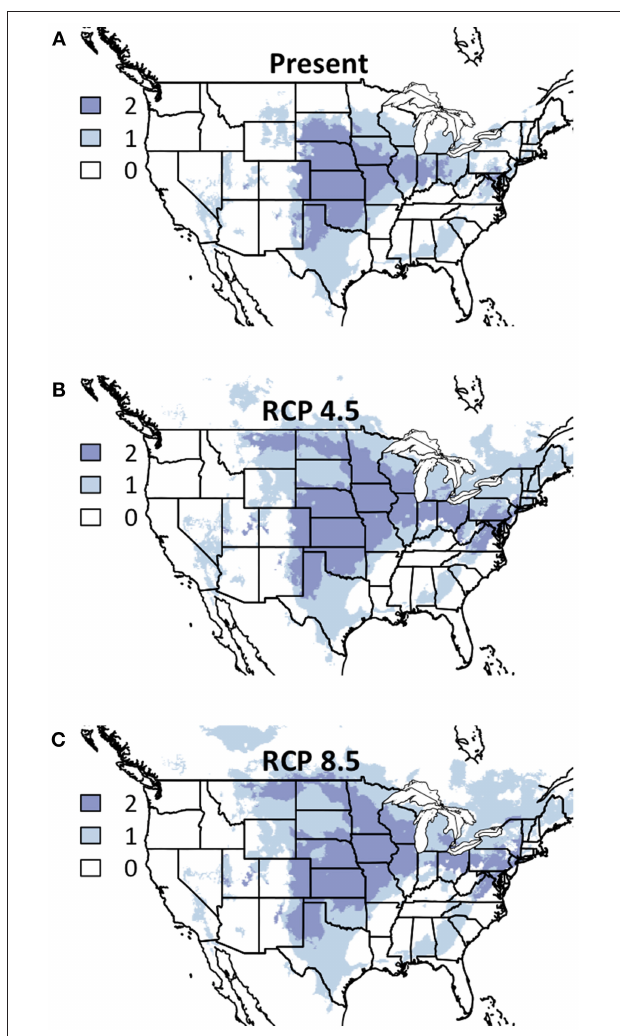
FIGURE 4 | Composite Map of Legume (A) Current Distribution and Response to (B) RCP 4.5 and (C) RCP 8.5. Colors indicate the number of species where suitability is predicted to ≥ 50%. Darker colors indicate areas where bioclimatic suitability is above the threshold for more species. Included species are Amorpha canescens and Dalea candida . Time period is identified in the top of each